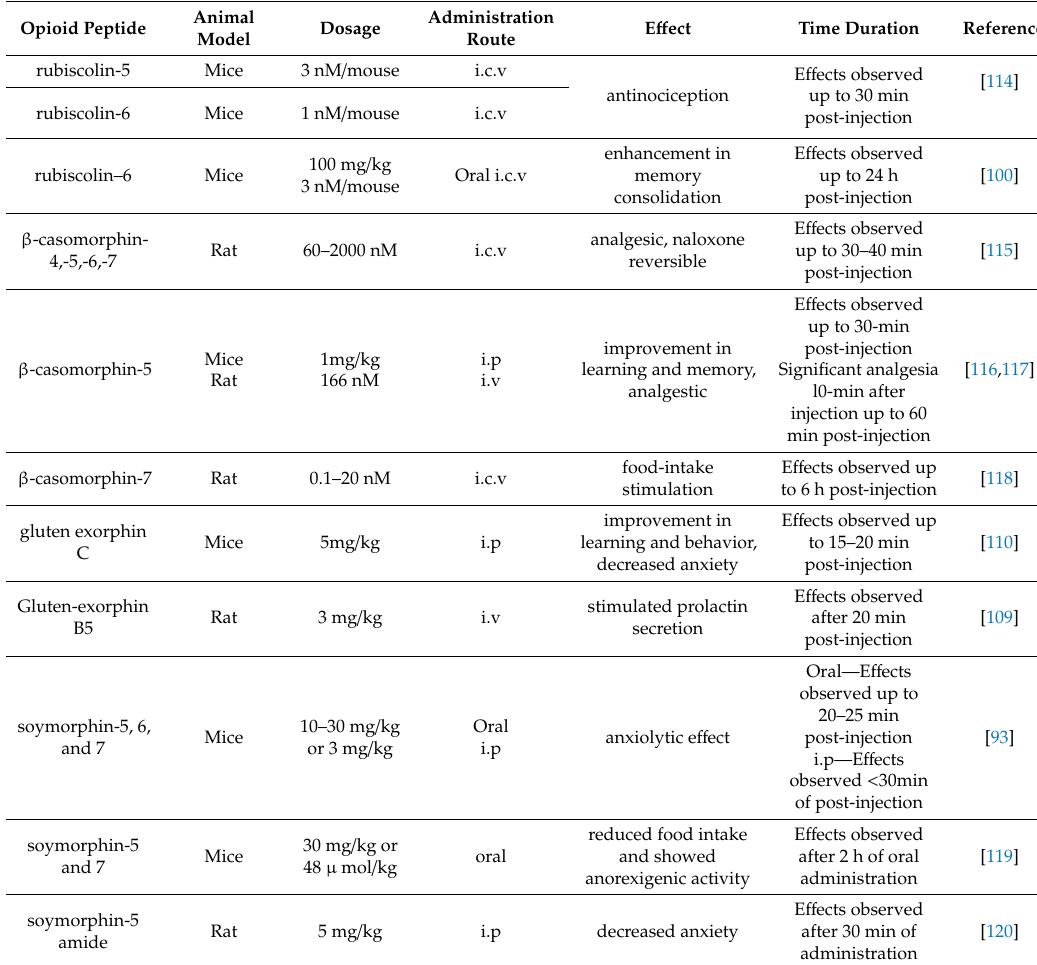
Table 5. Trials of exogenous opioid peptides in animal